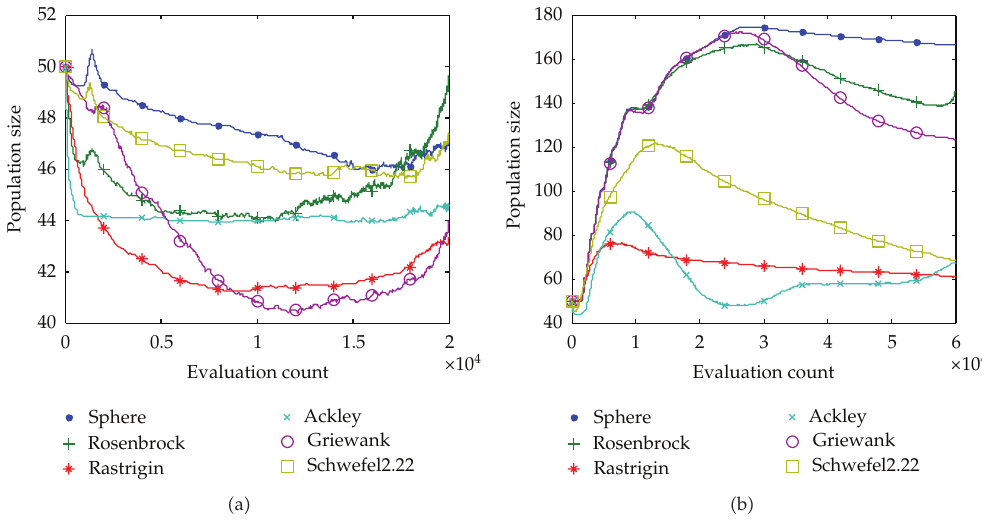
Figure 4: Mean population size varying plots of BFOLS on benchmark functions with dimensions of 2 (cid:2) a (cid:3) and 20 (cid:2) b (cid:3)